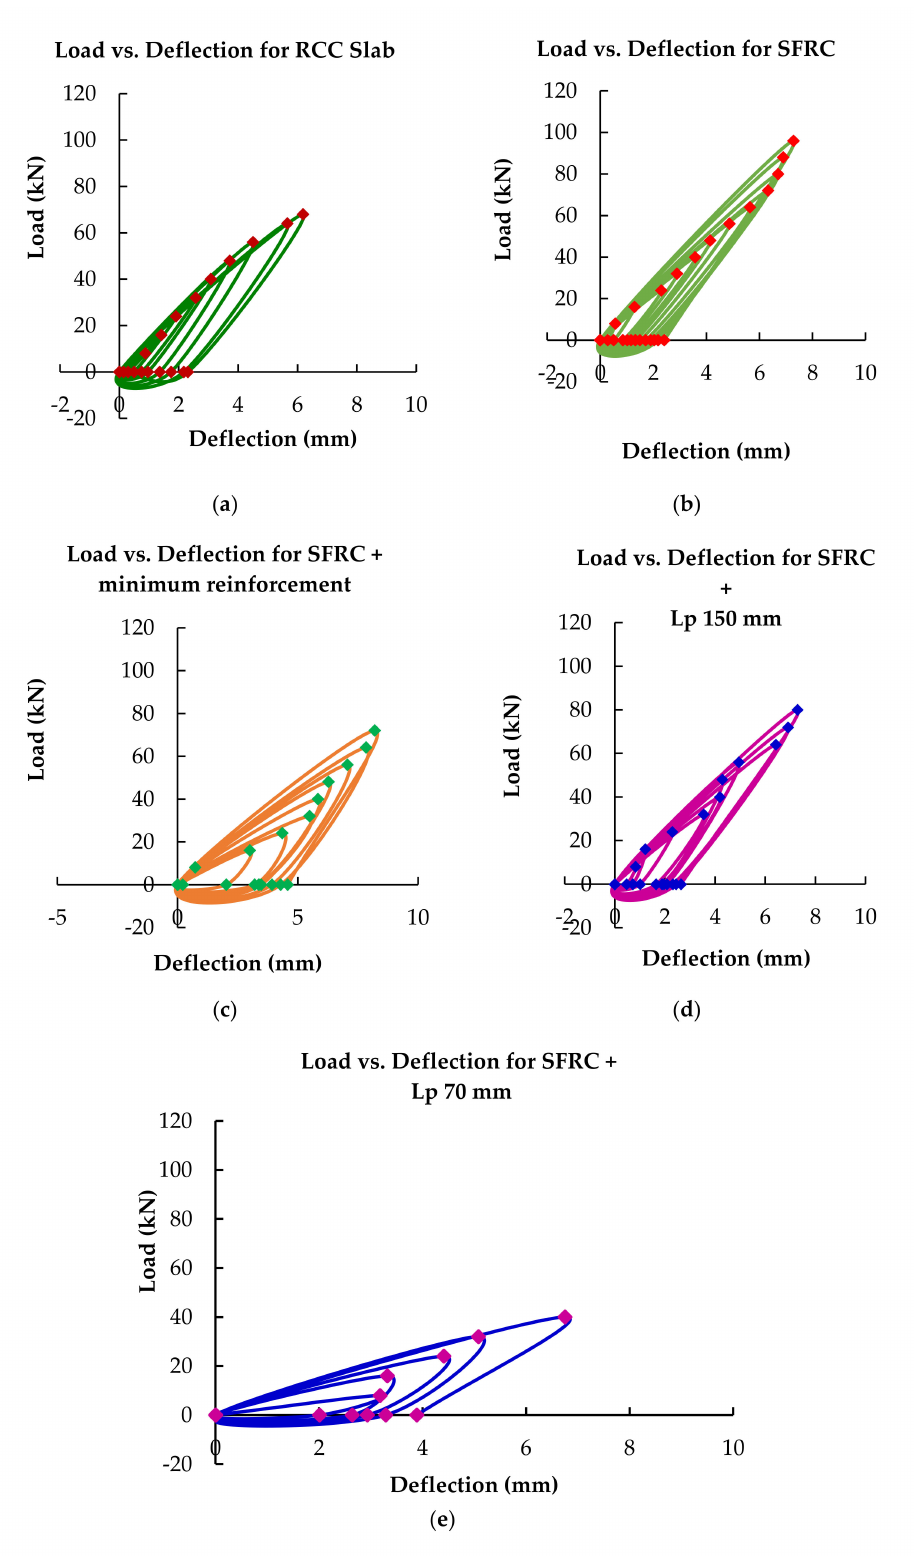
Figure 8. ( a ) Load versus deflection curve for RCC Slab; ( b ) load versus deflection curve for SFRC Slab; ( c ) load versus deflection curve for SFRC + Minimum reinforcement Slab; ( d ) load versus deflection curve for SFRC + Lp 150 mm; ( e ) load vs. deflection curve for SFRC + Lp 70